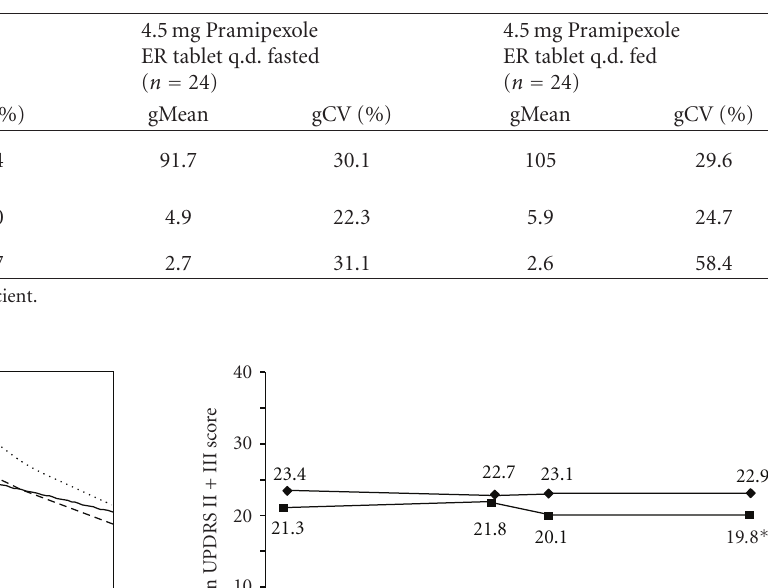
Table 1: Comparison of pharmacokinetic parameters in steady state after intake of Pramipexole IR 1.5 mg t.i.d., Pramipexole ER 4.5 mg q.d. fasted, and Pramipexole ER 4.5mg q.d. after fat and protein-rich meal.